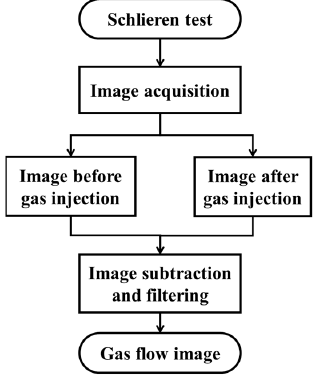
Figure 13. Image processing algorithm.